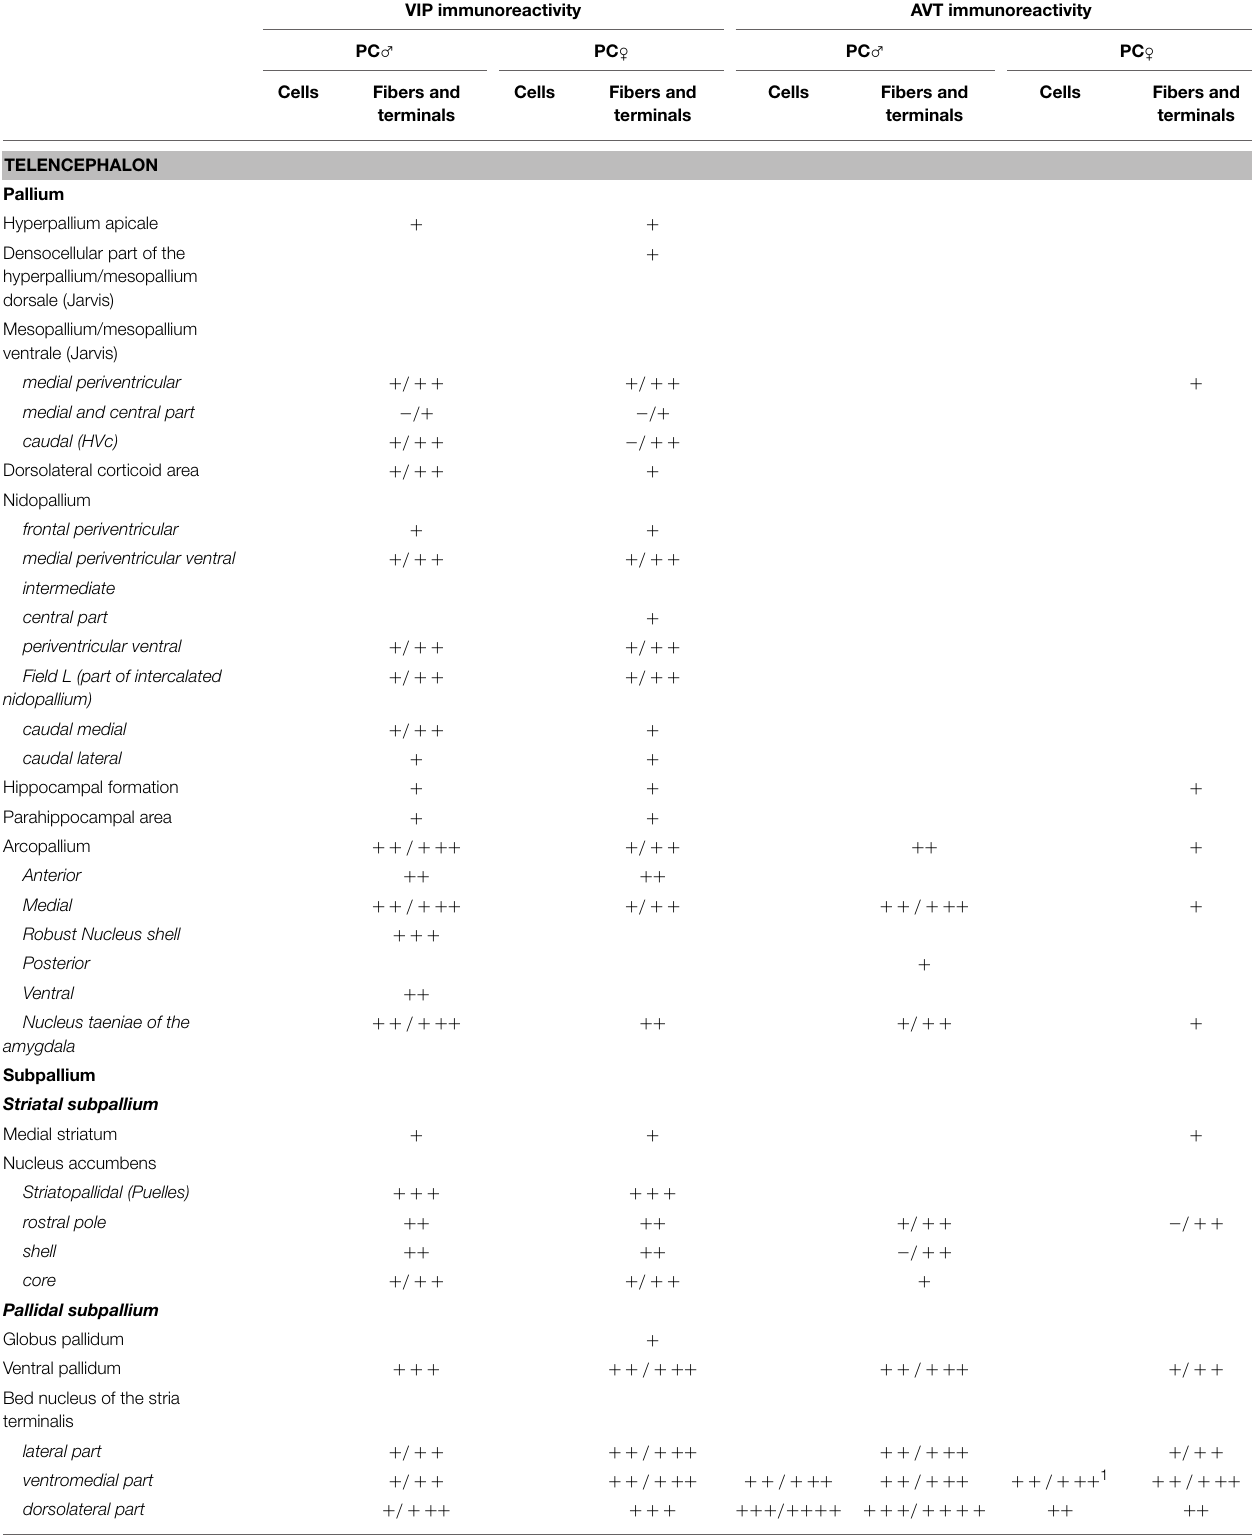
TABLE 1 | Distribution of VIP- and AVT-immunoreactive neurons, fibers and terminal fields in the brain of male and female blue tits. VIP immunoreactivity